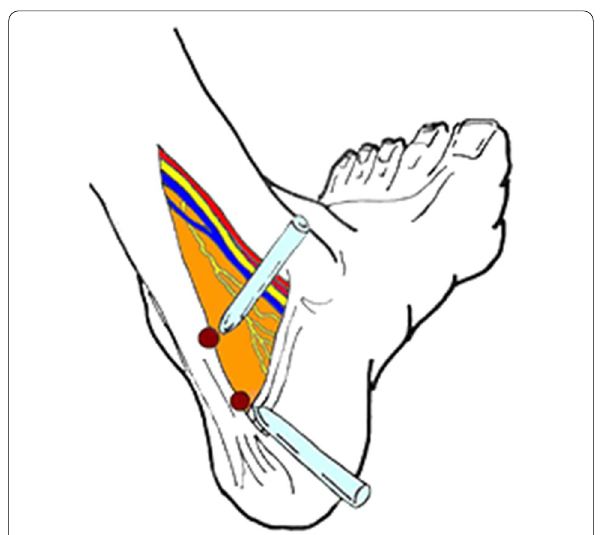
Table 2 Clinical results ( N